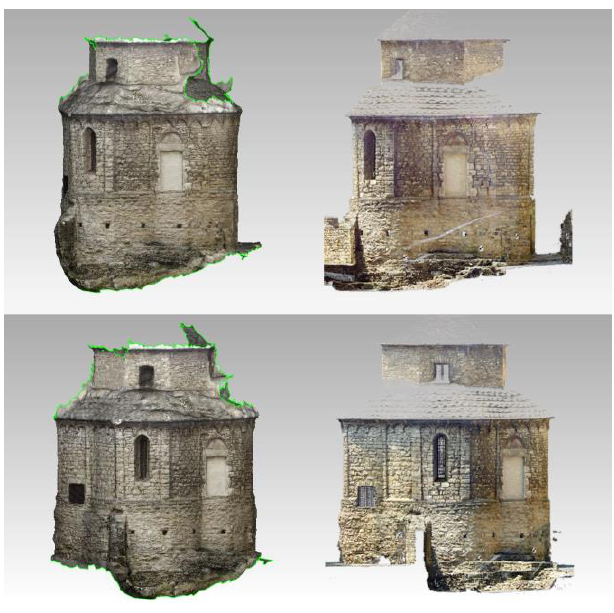
Fig. 6 A comparison between the orthophotos obtained by 3D image-based modelling and laser